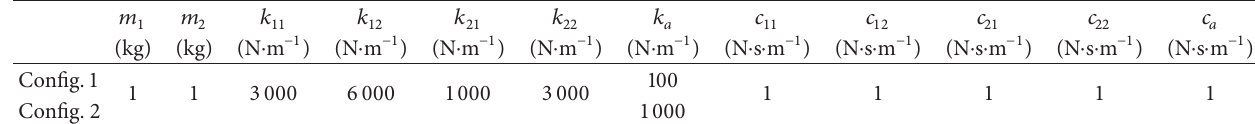
Table 2: Set of parameters under study for the mechanical